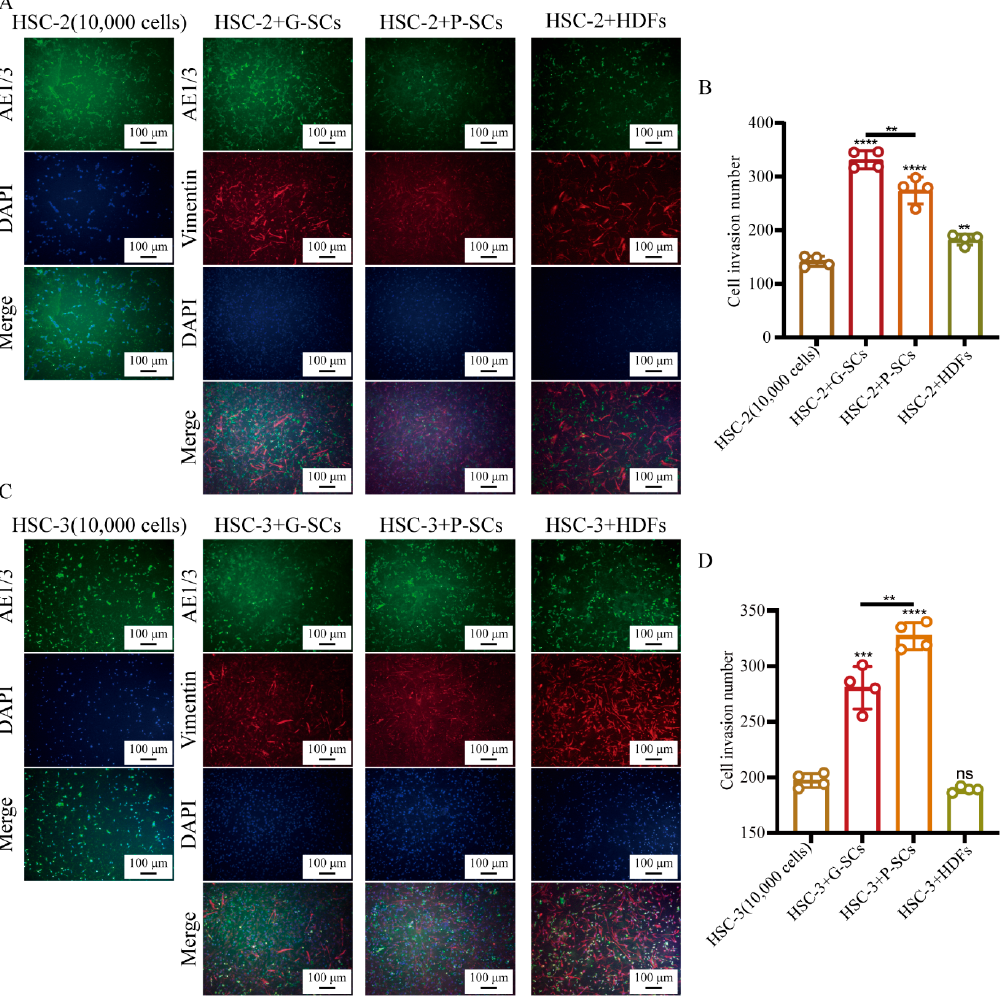
Figure 4. G-SCs and P-SCs promoted the invasion of OSCC cells in vitro. ( A , C ) The effect of G-SCs and P-SCs on the invasion of HSC-2 ( A ) and HSC-3 ( C ) was examined by transwell invasion assay. ( B , D ) Quantification of cell invasion number in different groups of HSC-2 ( B ) and HSC-3 ( D ). Data are shown as the mean ± s.d. (s.d., standard deviation), n = 4. Each group compared with HSC-2 (10,000 cells) and HSC-3 (10,000 cells) group, and statistical analysis was performed by Student’s t -test, ns indicates p > 0.05, ** indicates p < 0.01, *** indicates p < 0.001, **** indicates p < 0.0001.